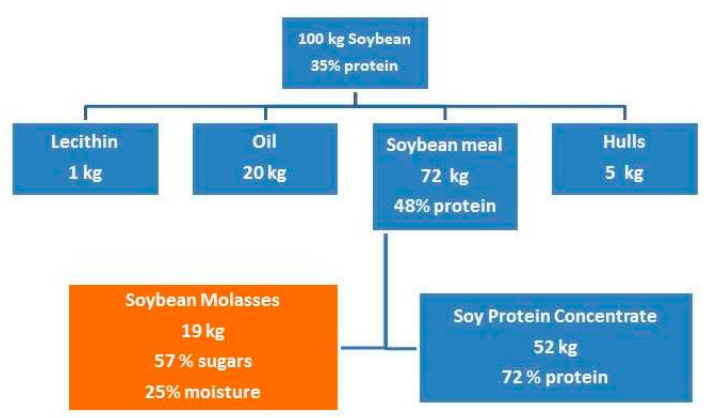
Figure 2. Products of the industrial processing of soybean (Source [22]) .